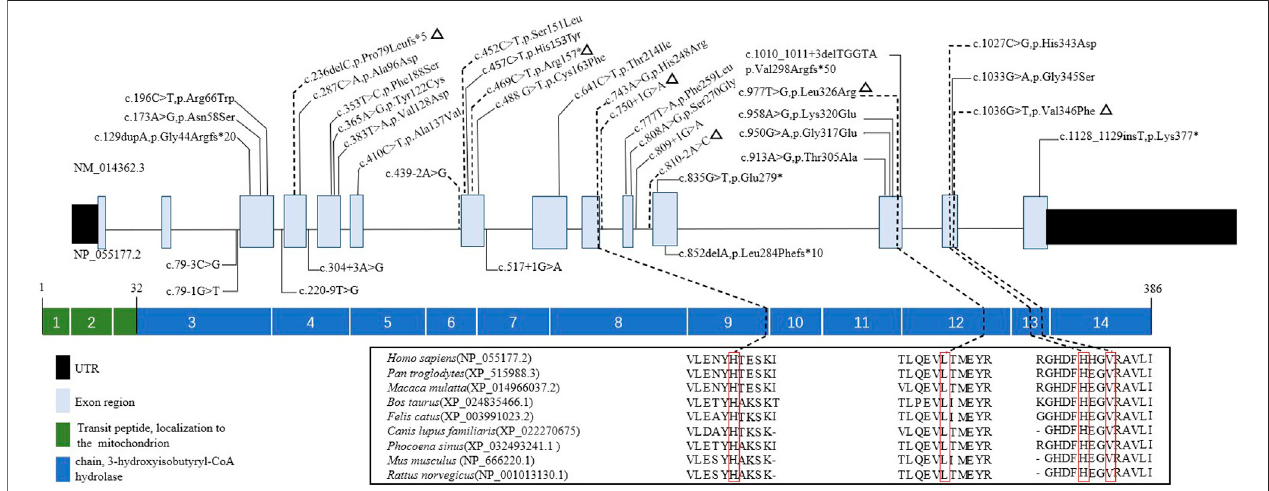
FIGURE 2| Schematic representation the HIBCH gene structure showing disease-associated mutation locations and conservation of mutant amino acid residues withknownproteindomains. Notes:dashedline,mutationsinourstudy;triangles,ournovelmutationsincludingmissense,splicing,frameshiftandnonsensemutations; solid line, mutations reported in the